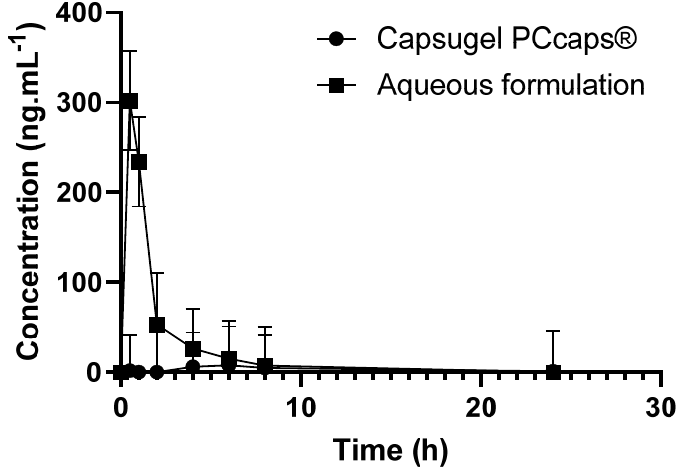
Figure 8. EGCG concentration as a function of time and of the formulation.